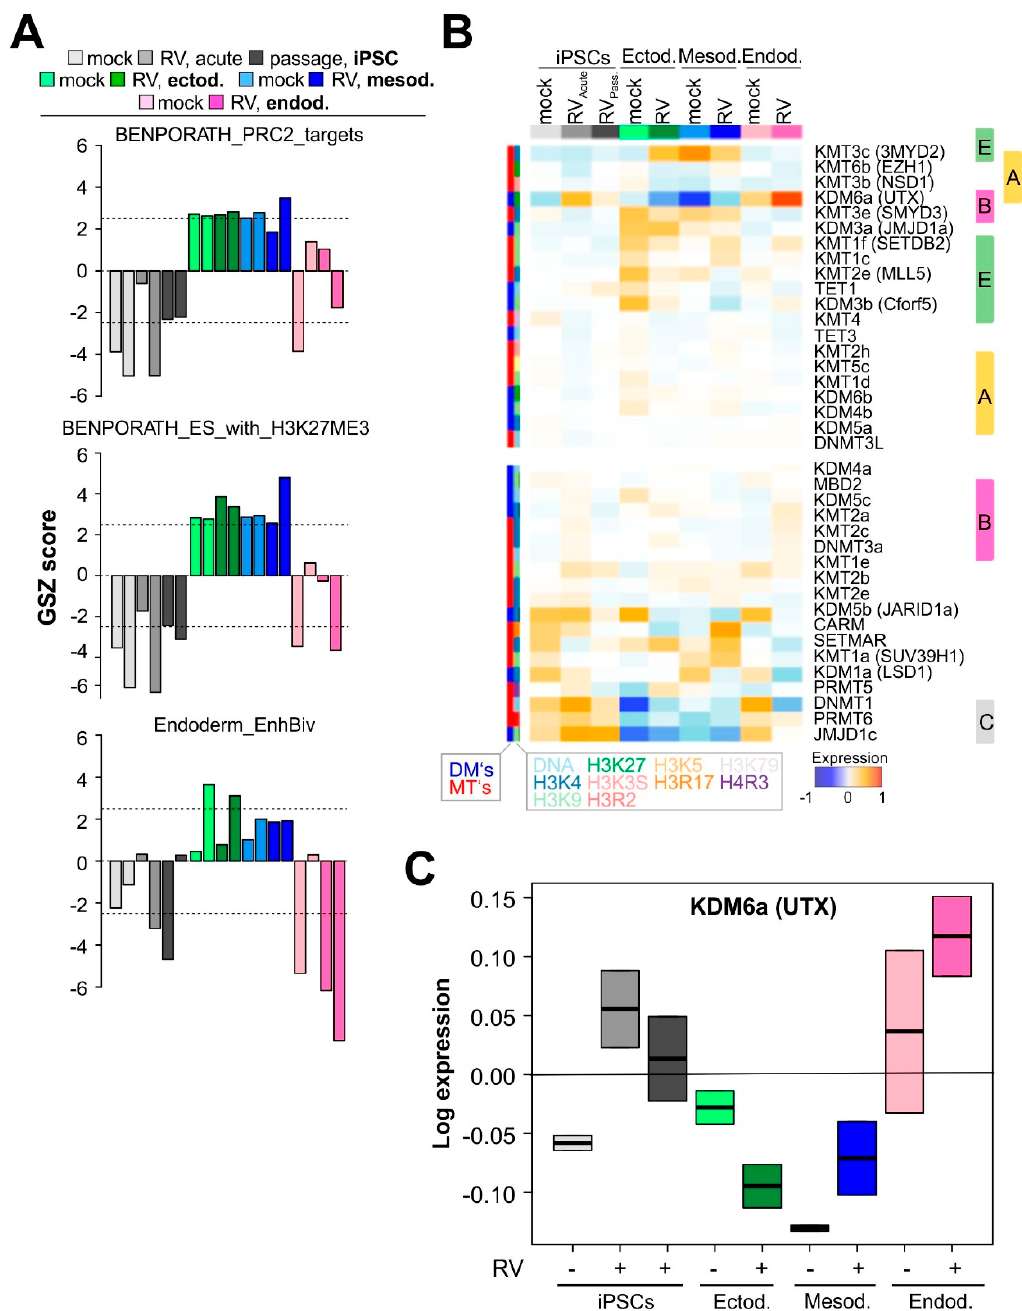
Figure 4. RV infection is accompanied by an altered expression of components of the SWI/SNF and NURF chromatin remodeling complexes. ( A ) Mean GSZ expression signatures of stemness-related transcriptional programs which act via epigenetic programming (PRC2 targets, repressive and bivalent chromatin marks). ( B ) Expression heatmap of chromatin modifying enzymes in the cell systems studied. The gene expression data of methyltransferases (MTs) and demethylases (DMs) of DNA cytosines, histone lysine and arginine side chains were assigned to the expression spot-cluster A–E according to their expression profiles. This suggests their involvement in the regulation of chromatin structure as writers and erasers of methylation marks at histone lysine and arginine side chains and affecting DNA methylation. Notably, a very strong variability was observed for KDM6a (alias UTX), a constituent of the SWI/SNF ATP-dependent chromatin remodeling machinery. ( C ) Expression of KDM6a directly relates to stemness programs (Figure 1F) and inversely relates to programs repressing stemness functions (part A of the Figure). See also Figure S4.